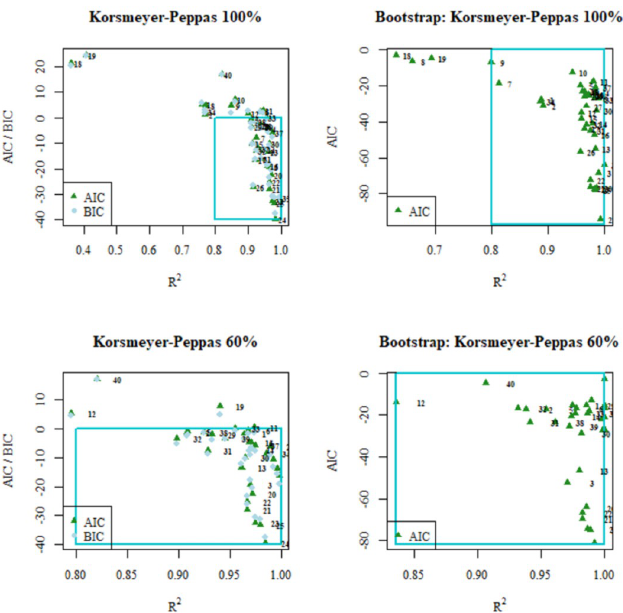
Fig 6. AIC / BIC vs R 2 plots obtained from linear regression fitting (left) and AIC vs R2 obtained from Bootstrap fitting (right) for the mathematical models of Korsmeyer-Peppas fitted to the entire release curve (top) and Korsmeyer-Peppas fitted to the first 60% of the release curve (bottom).